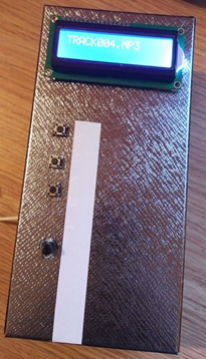
Fig. 5. Arduino -based portable mp3 player.